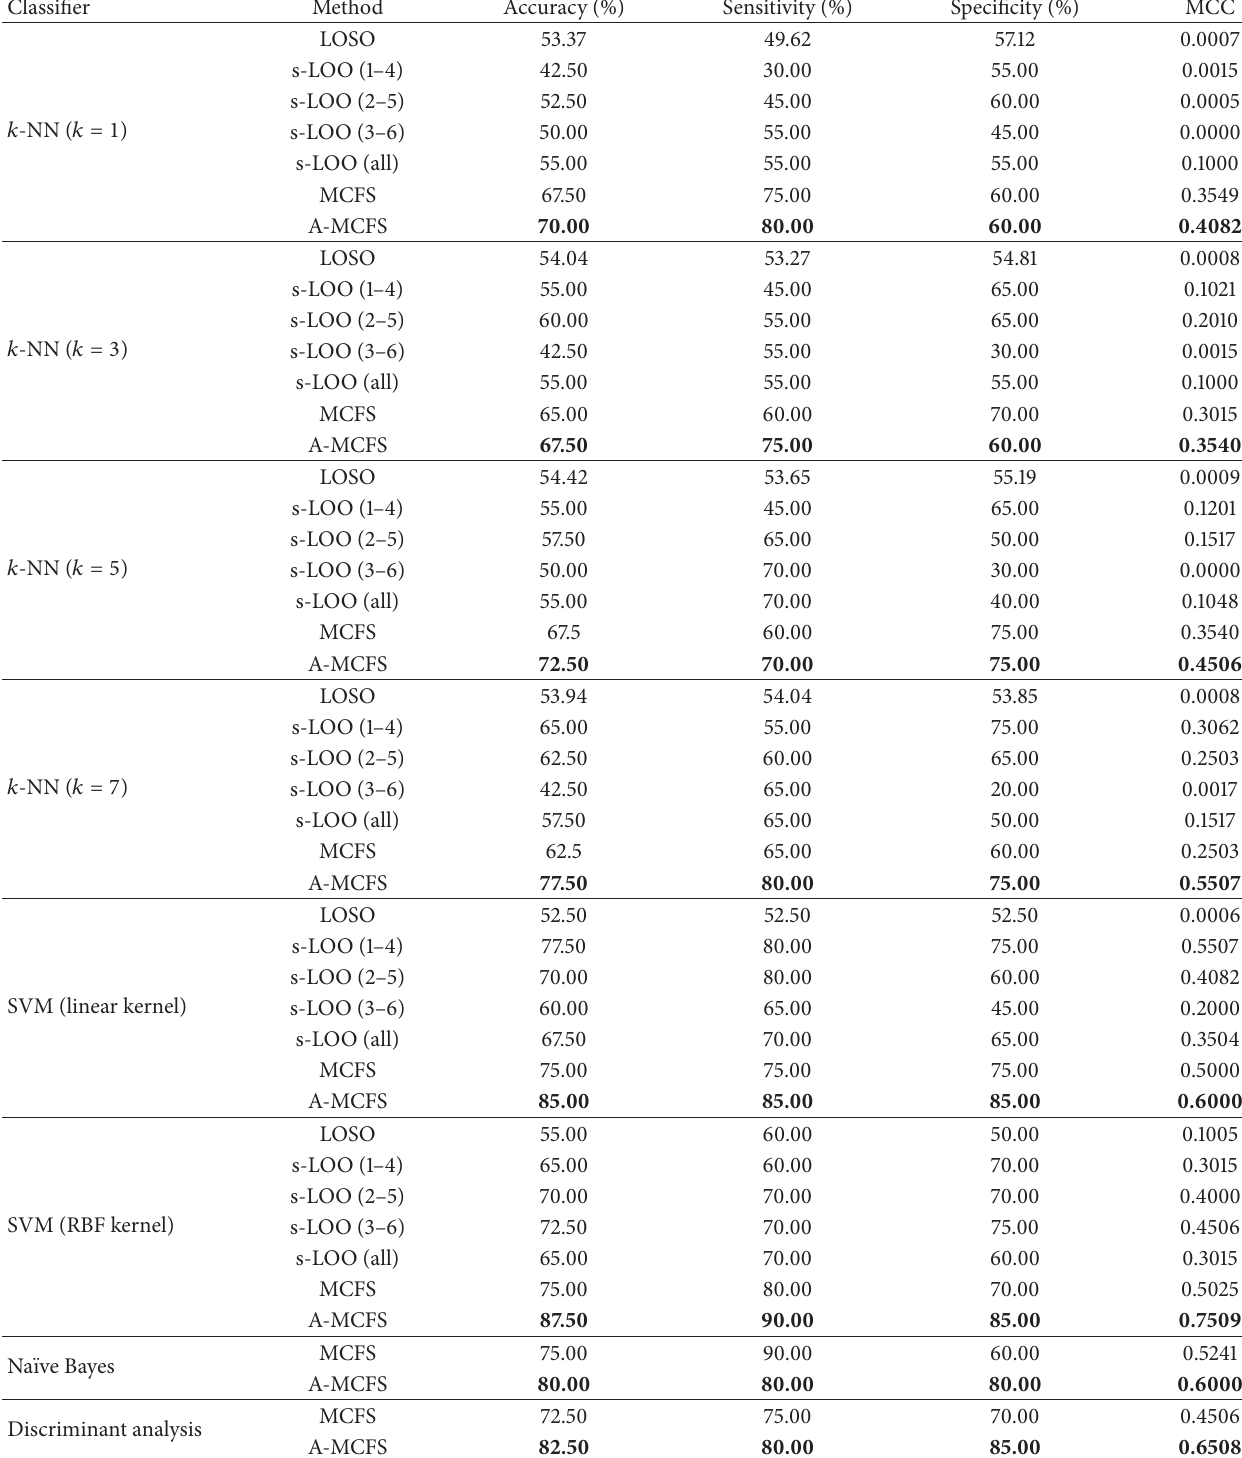
Table 3: Results obtained from applying different methods and